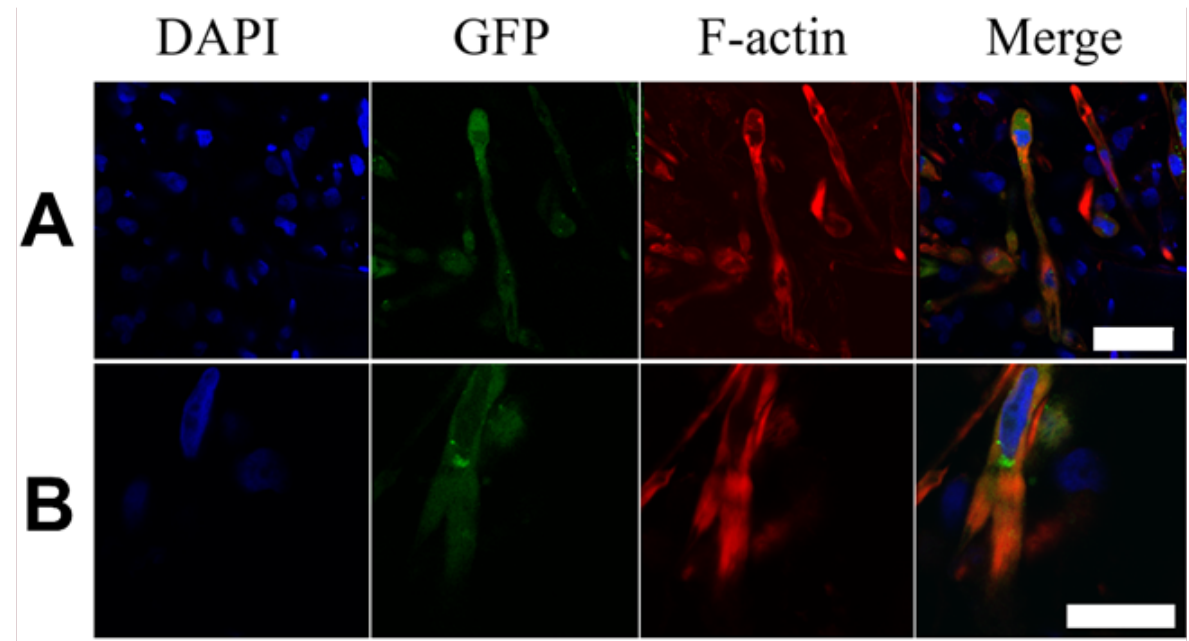
Figure 2. hPSC-CM show distinct characteristics of maturation after 100 days in culture. The staining of 100-day-old hPSC-CMC shows the DAPI signal of the cell nuclei (blue), cTNT-GFP CM control (GFP, green), F-actin (Phalloidin-TRITC, red), and a merge of these channels. Exemplary CM with ( A ) multiple nuclei and ( B ) typical branching are shown. Scale bars: 50 µ m ( A ), 25 µ m ( B